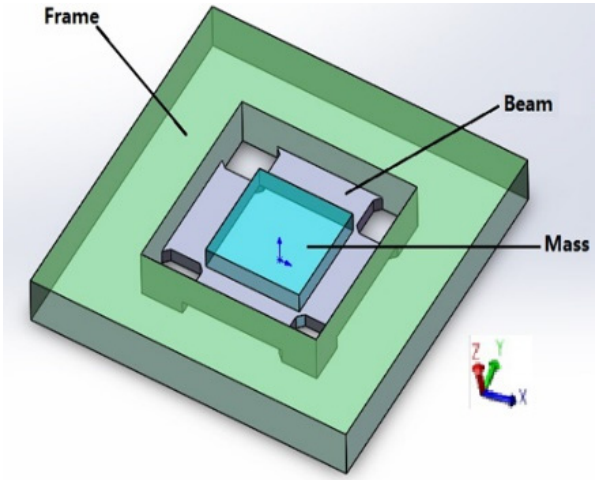
Figure 3. HGMA’s structure.